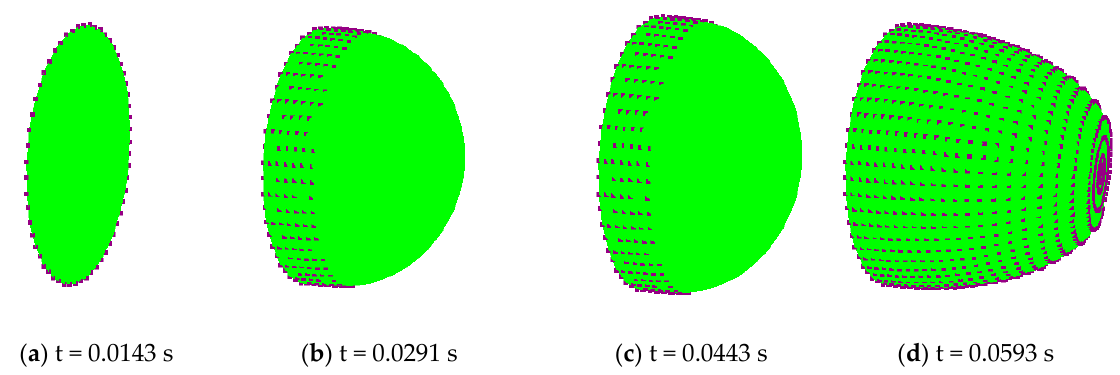
Figure 16. Evolution of the distribution of the contact nodes with the mold at at different instants: ( a ) time = 0.0143 s, ( b ) time = 0.0291 s, ( c ) time = 0.0443 s and ( d ) time = 0.0593 s.